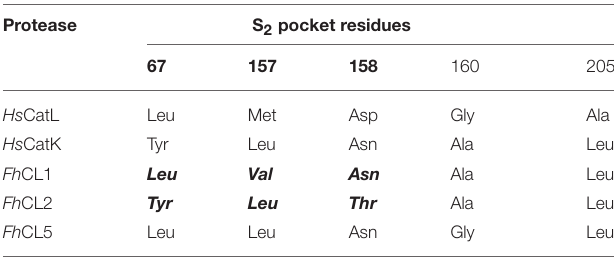
TABLE 1 | Residues found in the S 2 pocket of human cathepsin L and K ( Hs CatL, Hs CatK) and adult F. hepatica CLs.